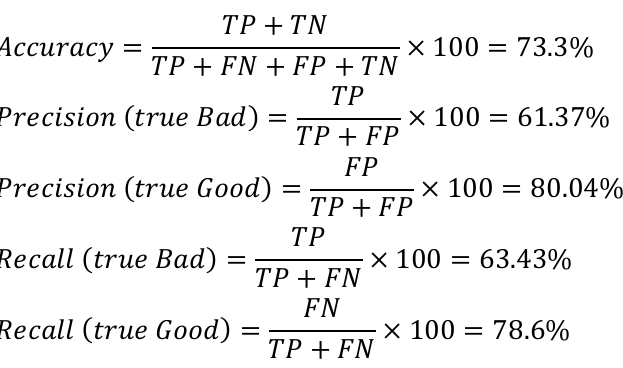
The results of decision tree Truly bad Truly good Class precision Predicted bad 170 107 61.37% Predicted good 98 393 80.04% Class recall 63.43%